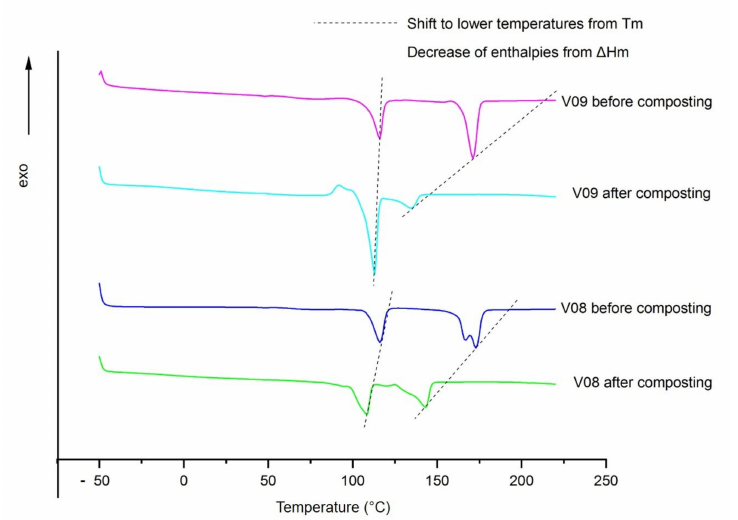
Figure 4. Exemplary DSC curves from filled blend systems before and after 12-week composting period. Compositions: PLA/PBS (7:3); V08: plus 15 phr coarse talc; V09: plus 15 phr